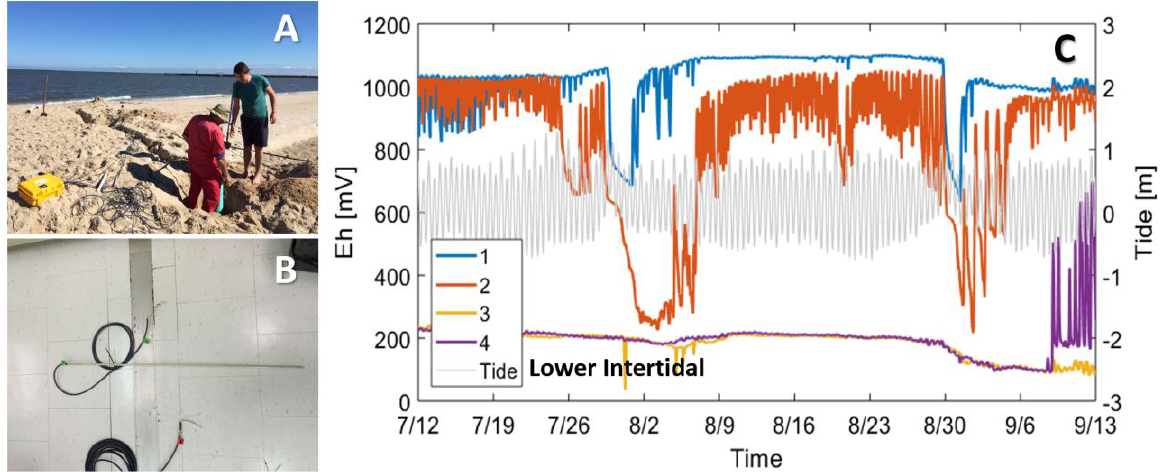
Figure 4. Multi-level redox sensors deployed along a beach transect to monitor hydrochemical variability. ( A ) Beach-perpendicular trench to bury wires leading from the redox sensors to a datalogger located near the high tide line. ( B ) Example redox sensor. The glass fiber rod contains platinum redox sensors spaced at specified vertical intervals. ( C ) Example redox time series from four multi-level redox sensors deployed in the lower intertidal zone during 2017. The colors indicate depth (blue; − 0.8 m, red; − 1.3 m, orange; − 1.6 m, and purple; − 2.1 m from surface). While the two top sensors (blue and red) showed response to diurnal and spring-neap tidal fluctuations (grey), the deeper two sensors (orange and purple) were less affected by tides, oscillating slightly over a month due to spring-neap variability in tidal amplitude.